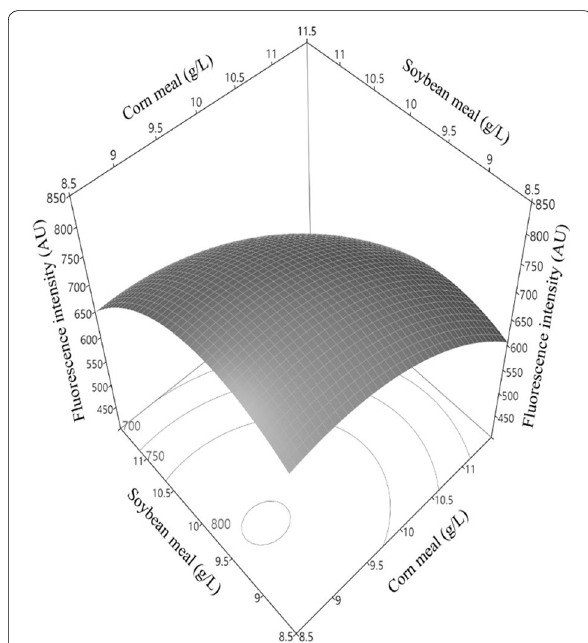
Fig. 3 Response surface plots for spore production caused by soy‑ bean meal and corn meal